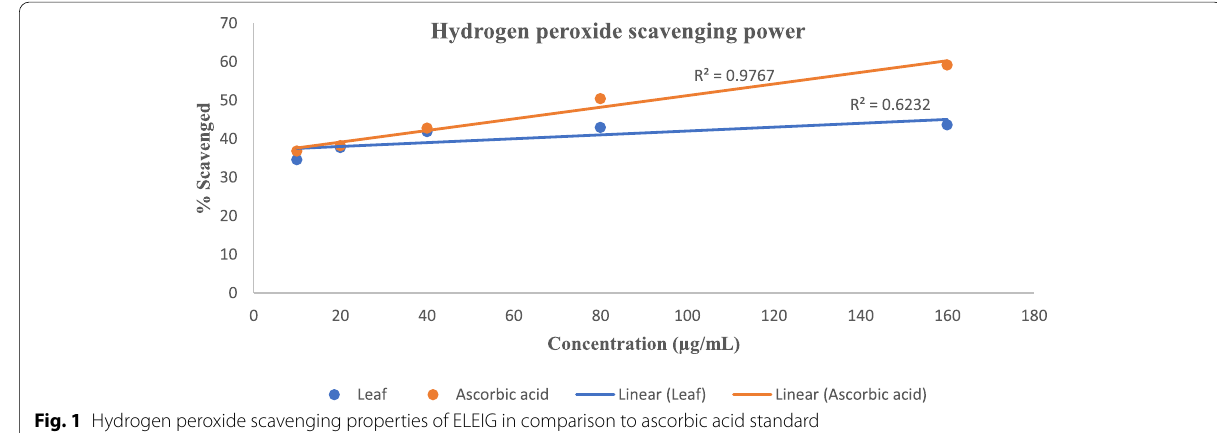
Fig. 1 Hydrogen peroxide scavenging properties of ELEIG in comparison to ascorbic acid standard